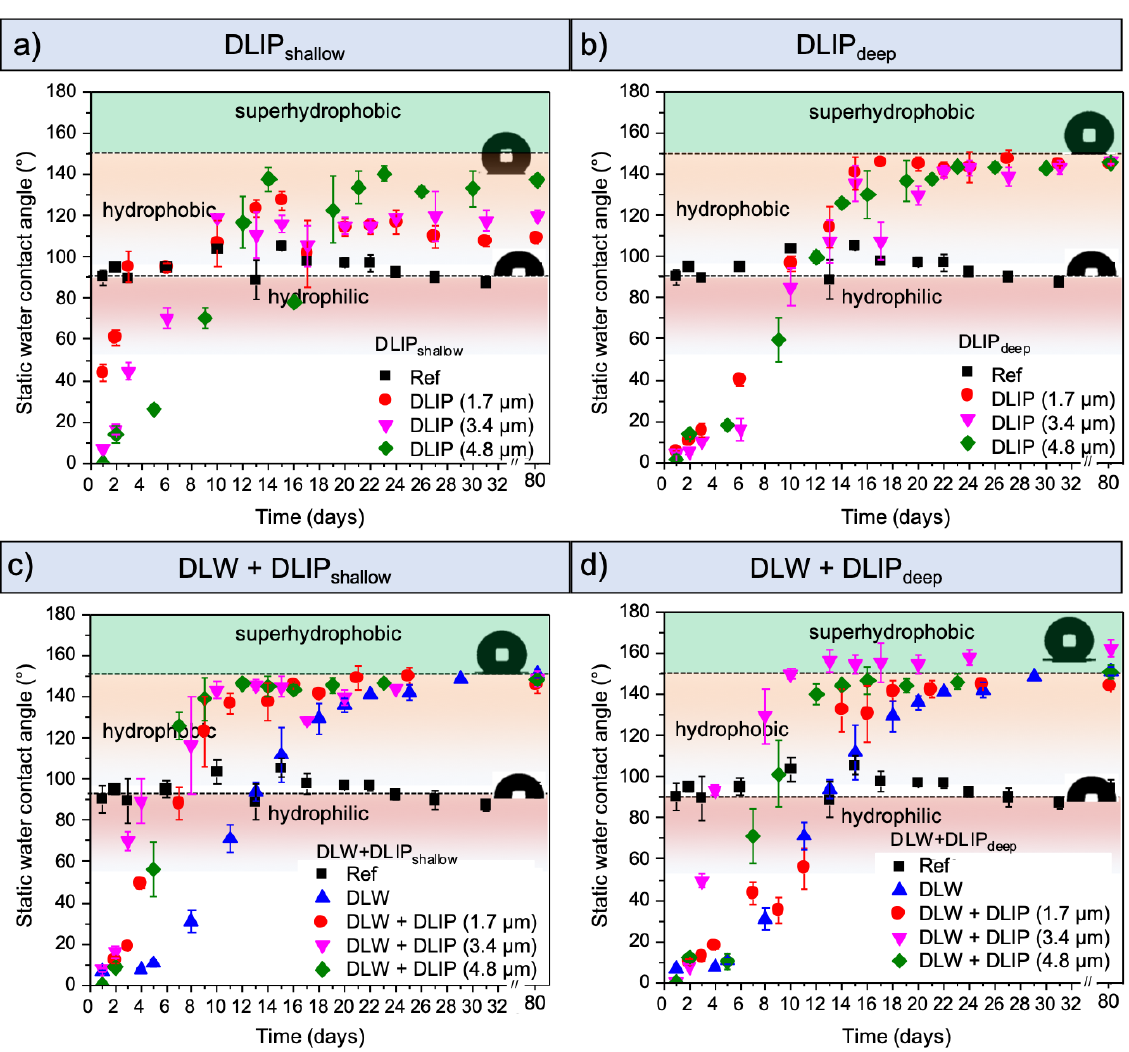
Figure 5. Evolution of static water contact angles for shallow homogeneous ( a ) and deep inhomogeneous ( b ) DLIP structures as well as multi-scale and DLW-containing structures with shallow ( c ) and deep ( d ) DLIP structure depths. The DLIP spatial period, in µ m, is indicated by the number in the square brackets.